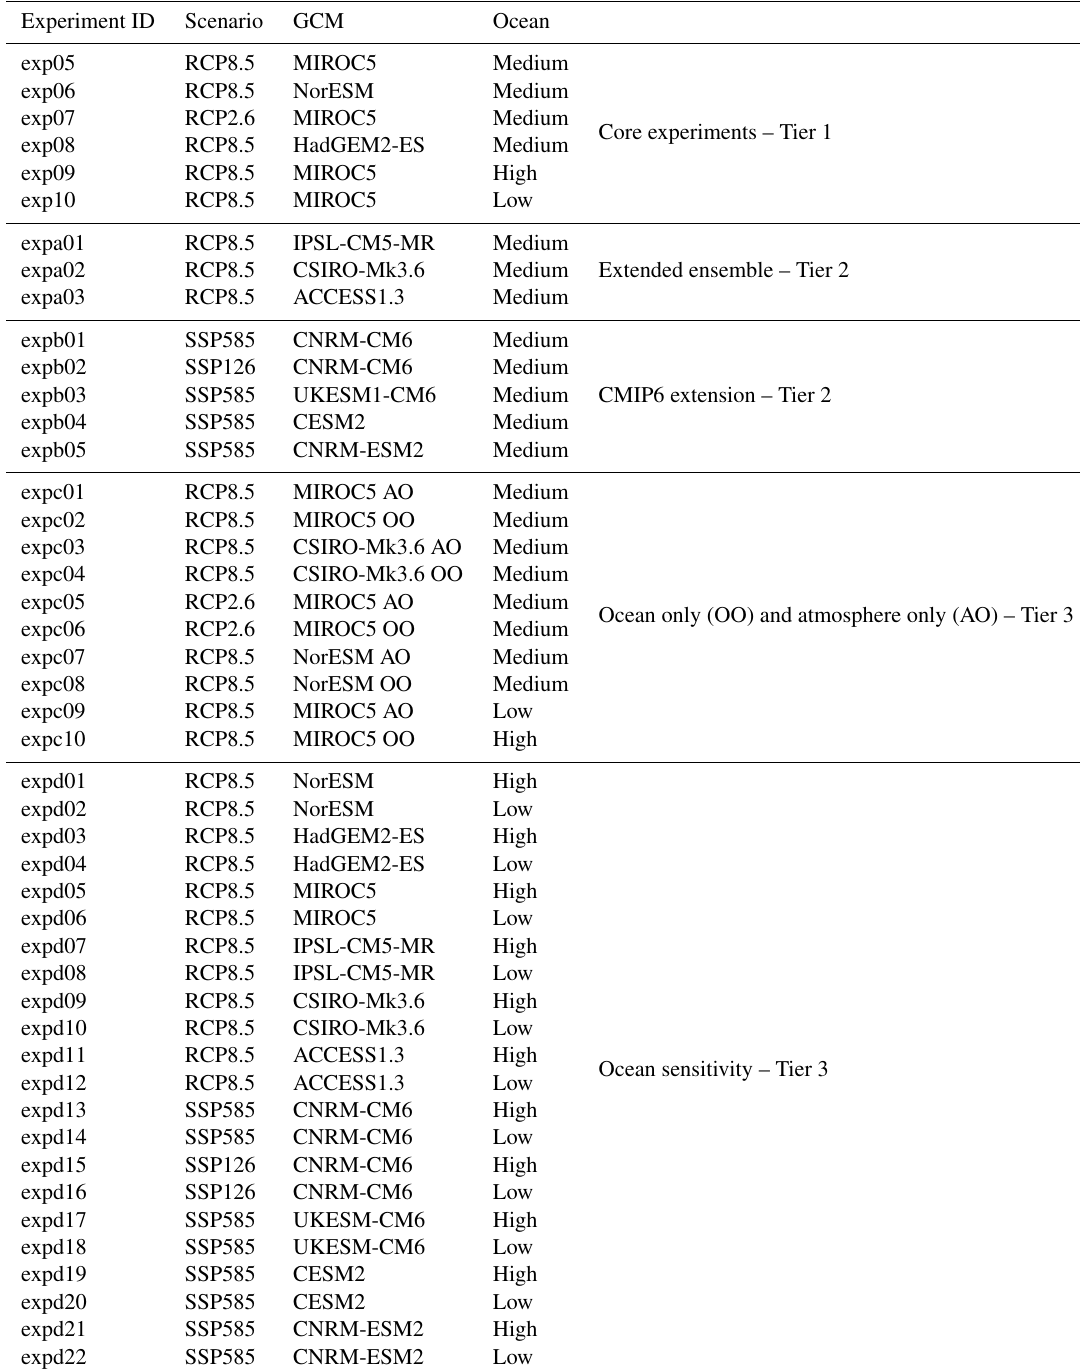
Table 1. List of ISMIP6-Greenland experiments performed in this work. Experiment